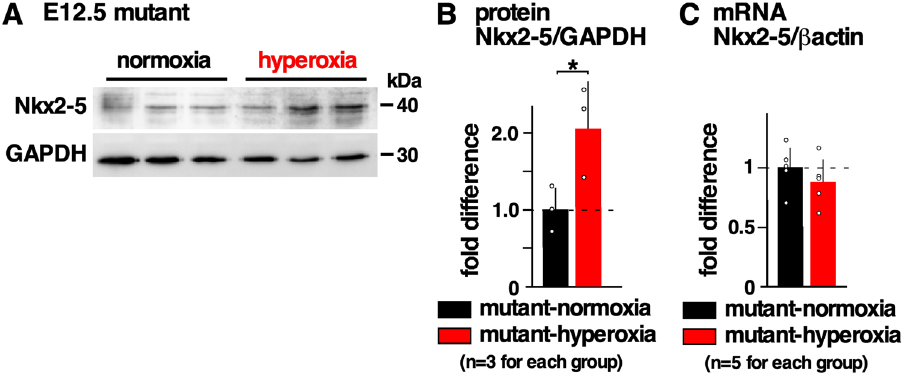
Figure 4. Expression of Nkx2-5 protein in E12.5 Nkx2-5 + /R52G embryonic hearts with or without hyperoxia. ( A ) Representative Western blotting demonstrating Nkx2-5 and GAPDH proteins (see Supplemental Fig. S1). ( B ) Quantitative data for Nkx2-5 protein expression relative to GAPDH. ( C ) Real-time reverse transcriptase PCR of Nkx2-5 mRNA relative to ß-actin. The value in the Nkx2-5 mutant-normoxia was defined as 1. The Mann– Whitney U-test was used for analysis. Data are expressed as mean ± S.D.; individual data are represented as circles. * P ≤ 0.05. ImageJ 1.52d (http:// imagej. nih. gov/ ij) was used for